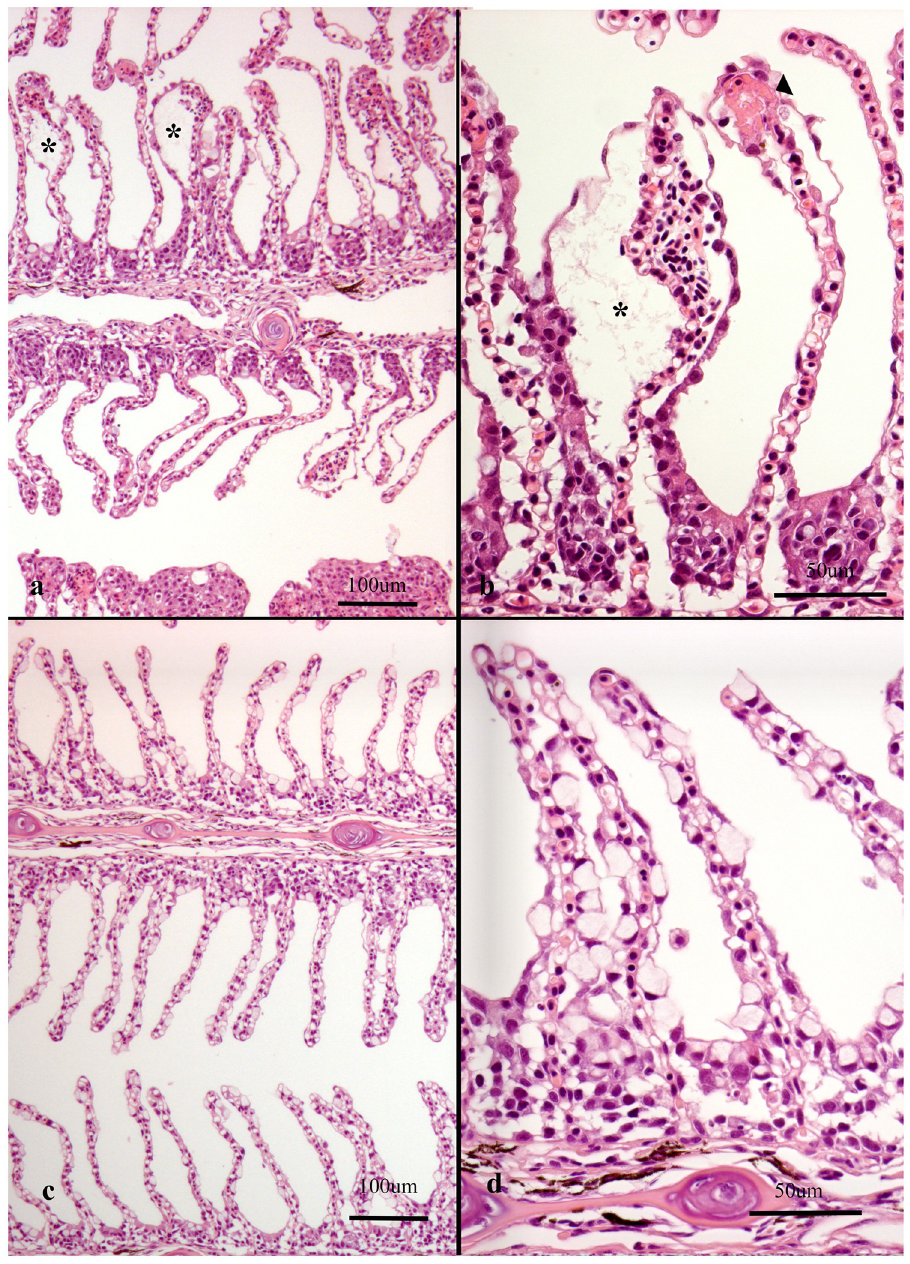
Fig 5. Histological sections of gills from Atlantic salmon. Note that plane of section is consistently on the efferent side of the gills in all images as judged by the small amount of filament cartilage. (a-b) Gills from farm 3 were dominated by Ca . Branchiomonas cysticola and Desmozoon lepeoptherii . (a) some lamellar adhesion and subepithelial oedema (asterisk), scored 2, (b) manifestation of subepithelial oedema (asterisk) and thrombosis (arrowhead). (c-d) mucus cell hyperplasia scored